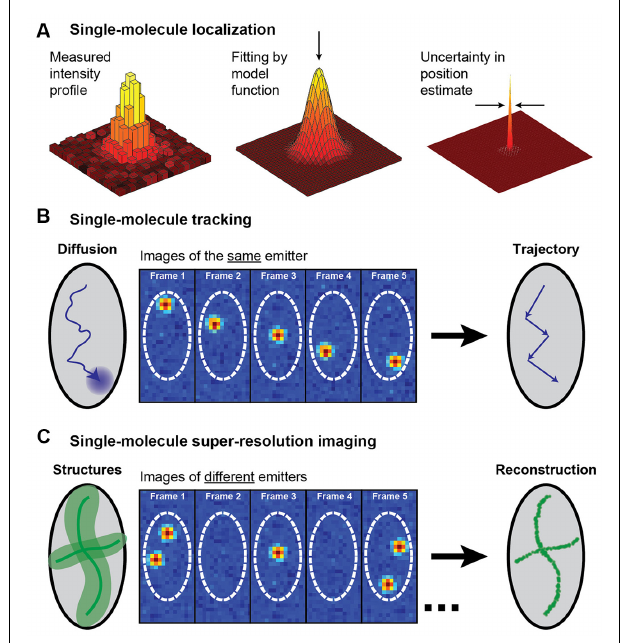
FIGURE 2 | Schematic illustrating single-molecule super-localization, tracking, and super-resolution imaging. (A) The noisy diffraction-limited pattern of an isolated fluorophore’s intensity profile on the camera can be fit with a model function, such as a 2D Gaussian, to estimate the position of the fluorophore with a precision that is better than the diffraction limit. (B) In single-molecule tracking, the same single fluorophore is super-localized over multiple frames to create a trajectory that yields information about the fluorophore dynamics. (C) A diffraction-limited image with all molecules fluorescing simultaneously can be super-resolved by sequentially super-localizing many different spatially isolated molecules. This approach requires some active control to allow just a small fraction of the fluorophores to emit in each camera frame. Figure reprinted with permission from von Diezmann et al. (2017). Copyright (2017) American Chemical